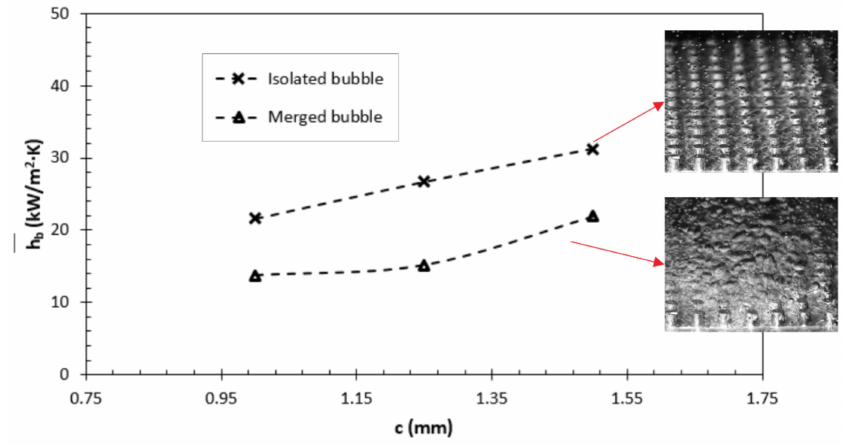
Figure 8. Boiling heat transfer coefficient in different fin gaps from circular pin fin arrays.